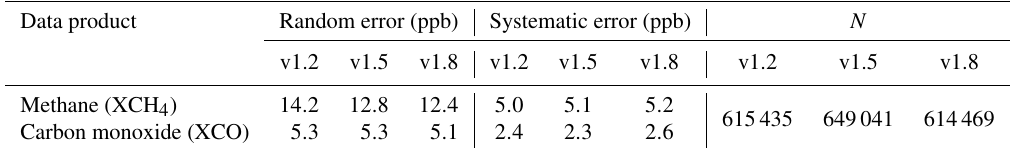
Table 2. Comparisons of the most important figures of merit for the different TROPOMI/WFMD product versions obtained by validation with the GGG2014 version of TCCON data at 26 sites (see Table B1). The random error is measured by the scatter of the satellite data relative to the TCCON, and the systematic error is a combination of the spatial station-to-station bias and the seasonal bias. N is the total number of collocations for all sites together.